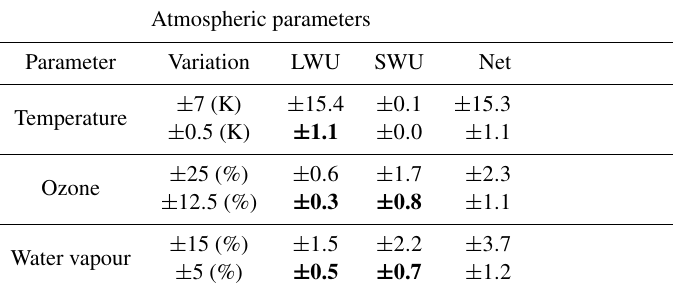
Table A3. Variation of several atmospheric parameters. The table indicates the mean upward SW (SWU), LW (LWU), and net flux differences at the top of the atmosphere (TOA) of clear-sky (CS) perturbed simulations minus the created idealized atmosphere. Values in Wm − 2 . Values highlighted in bold are used as uncertainties.